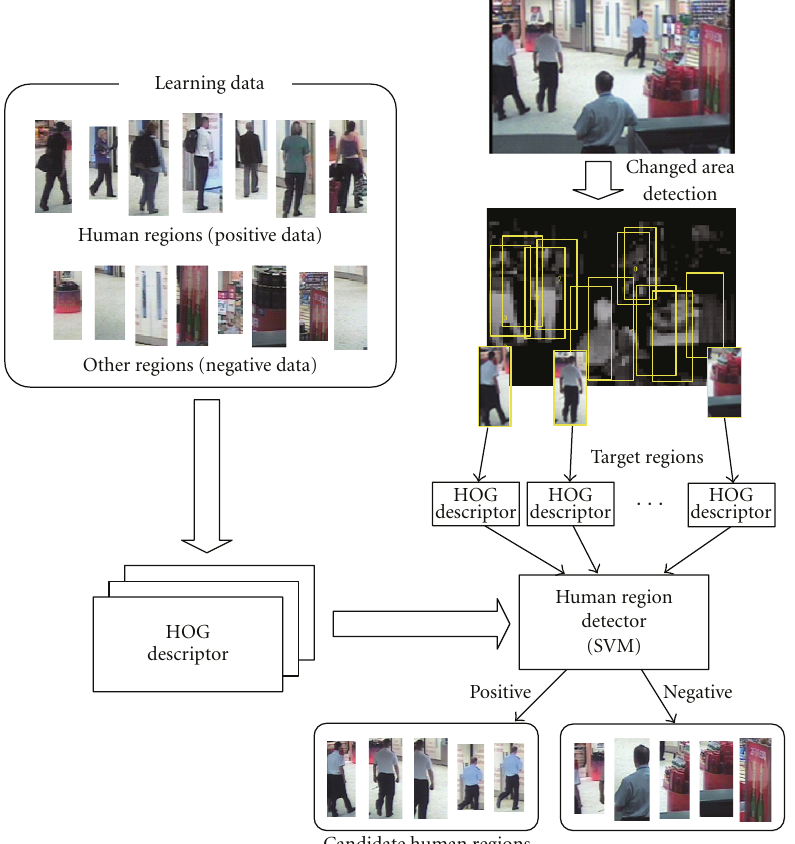
Figure 9: Detecting candidate human